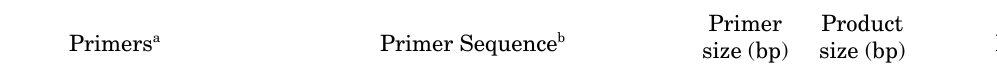
Primers a Reference